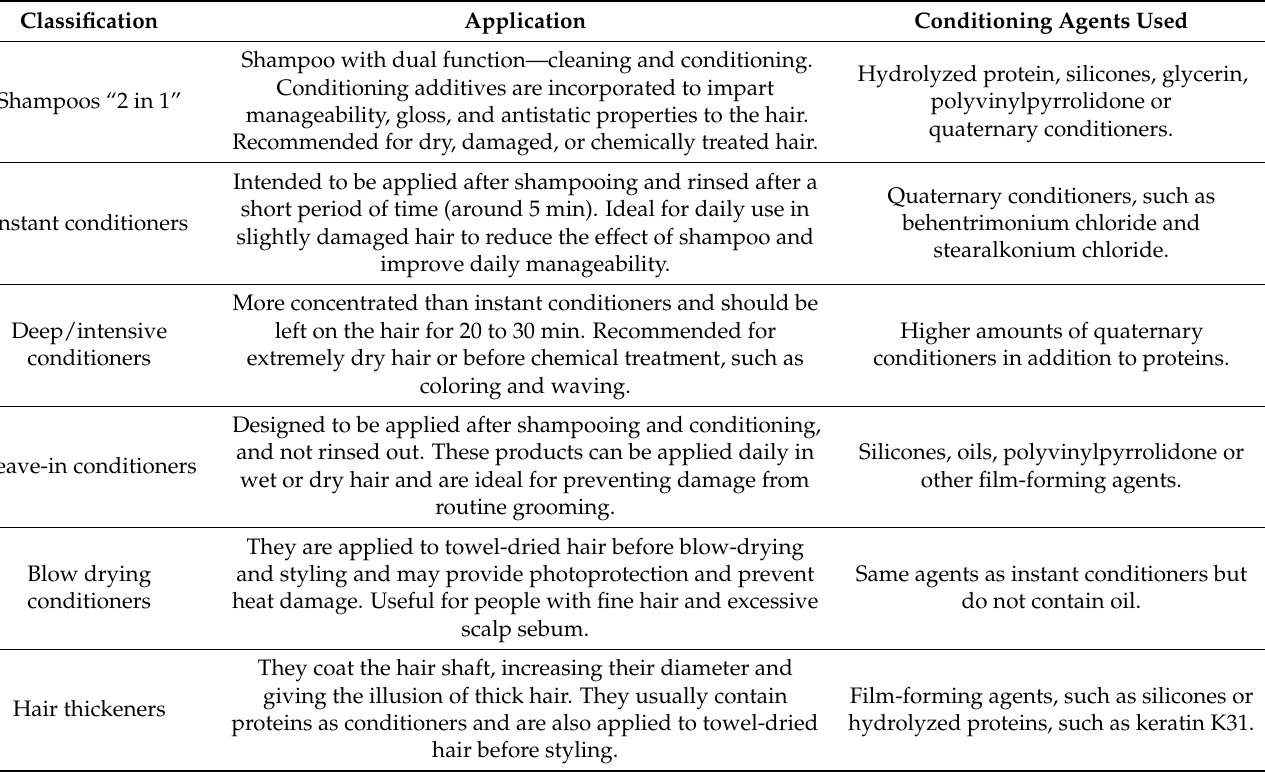
Table 1. Types of hair conditioner products and their intended